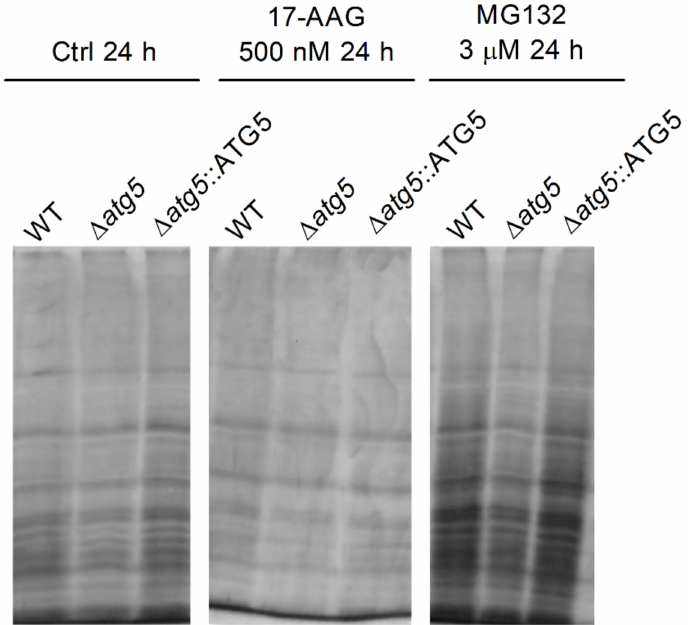
Figure 6. Effect of 17-AAG treatment on WT, ∆ atg5 and ∆ atg5 ::ATG5 protein aggregate formation. Culture aliquots from WT, ∆ atg5 and ∆ atg5 ::ATG5 parasites treated with 17-AAG (500 nM) or MG132 (3 µ M) for 24 h were withdrawn and analyzed to determine quantities of insoluble protein aggregates by cell lysis and centrifugation. Protein aggregates were subjected to SDS-PAGE followed by silver staining. One experiment is representative of two independent